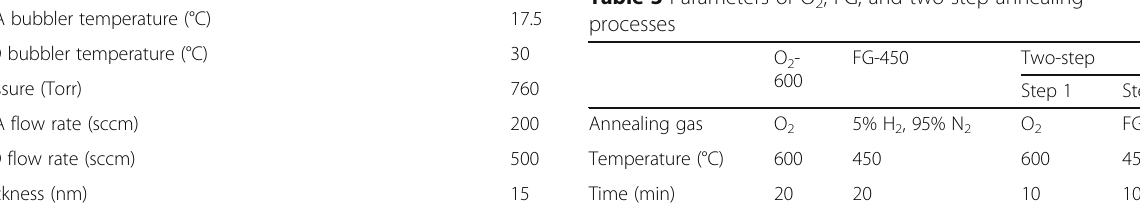
Table 3 Parameters of O 2 , FG, and two-step